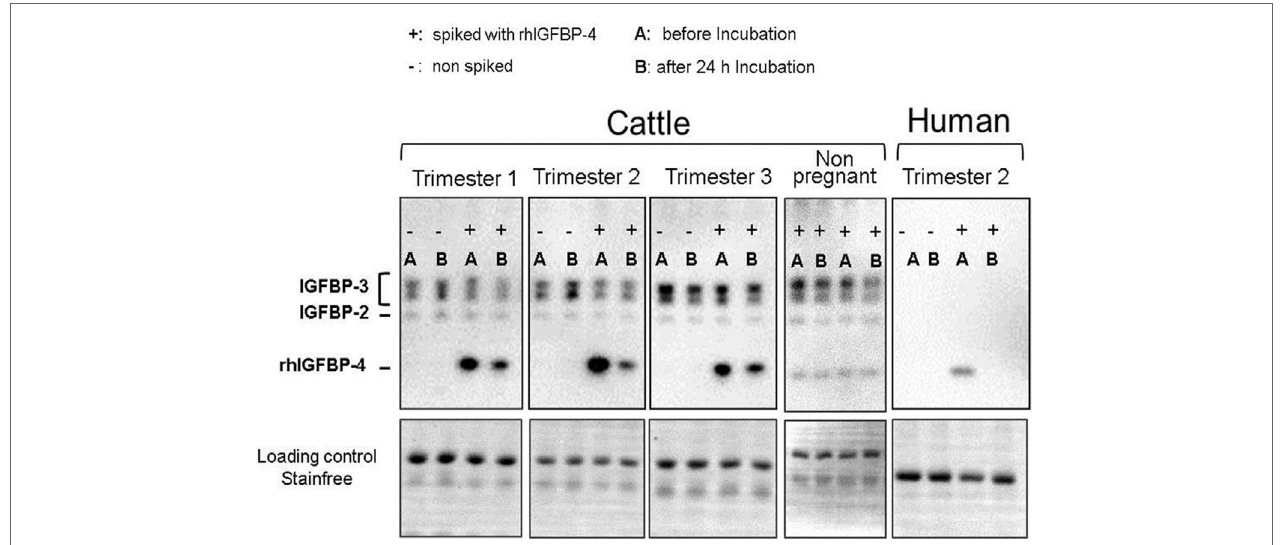
FigUre 5 | Western ligand blots with serum samples of not-pregnant and pregnant cows before ( − I) and after ( + I) incubation (24 h, 39°C) with Insulin-like Growth factor 4 (IGFBP-4) and insulin-like growth factor 1 (IGF-1) spiked to the serum. As positive control serum of a pregnant woman was available for which proteolytic activity IGFBP-4 is clearly